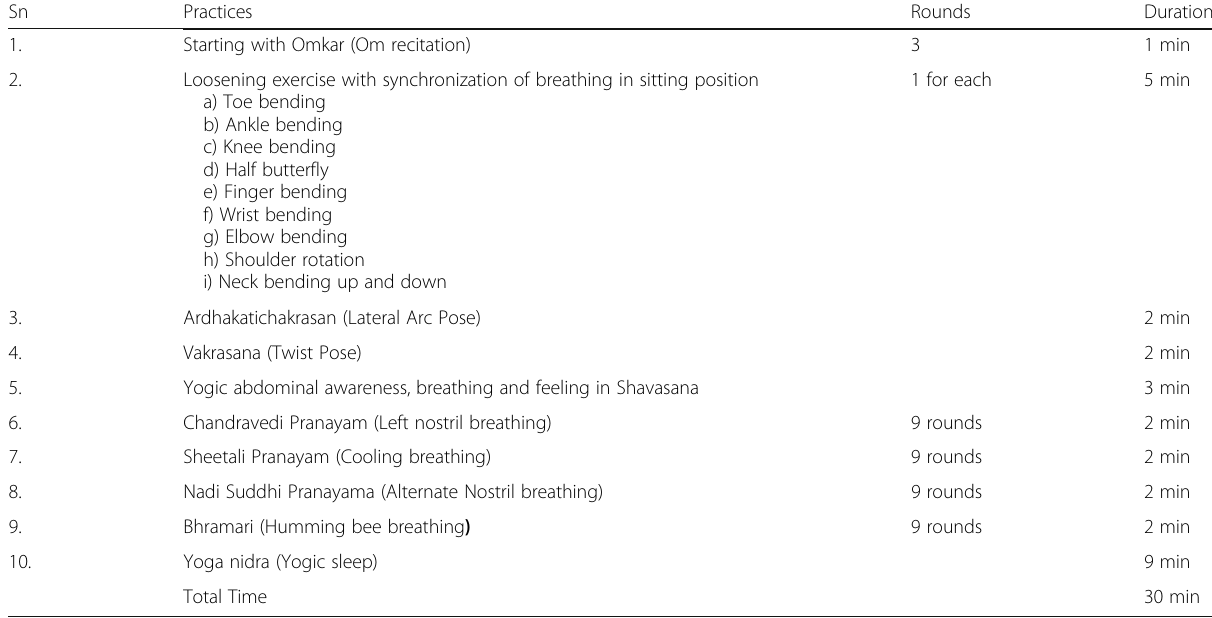
Table 1 Yoga module for the study participants Sn Practices Rounds